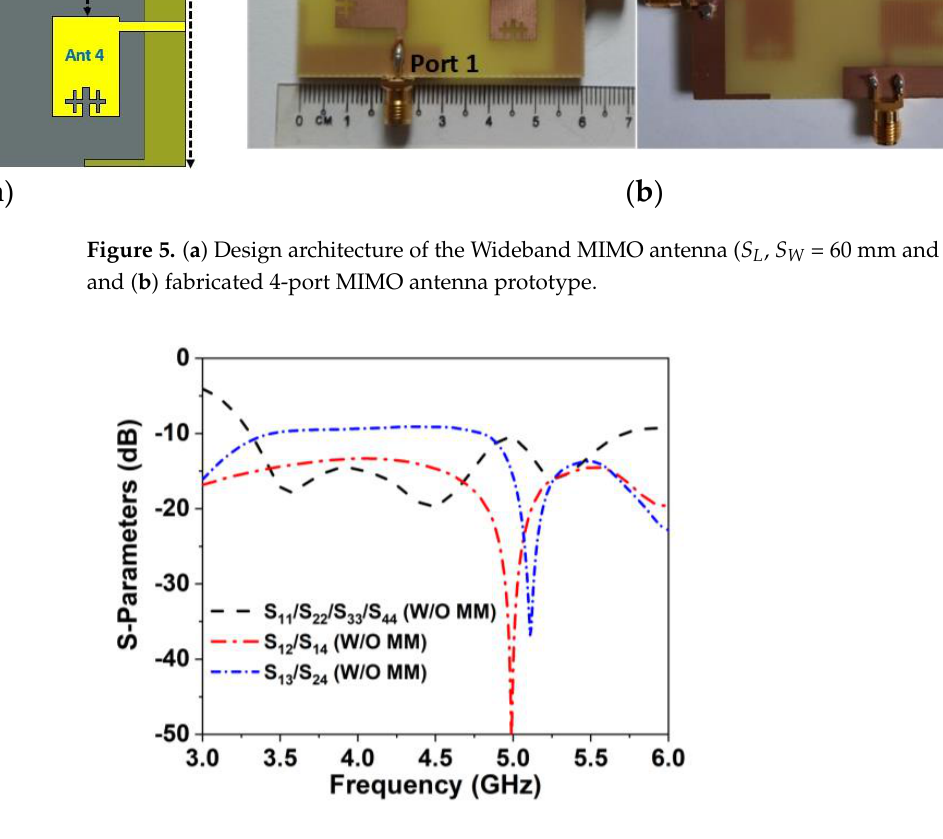
Figure 6. Simulated performance of reflection coefficient (S 11 , S 22 , S 33 , and S 44 ) and isolation between MIMO adjacent and diagonal components (W/O: without).